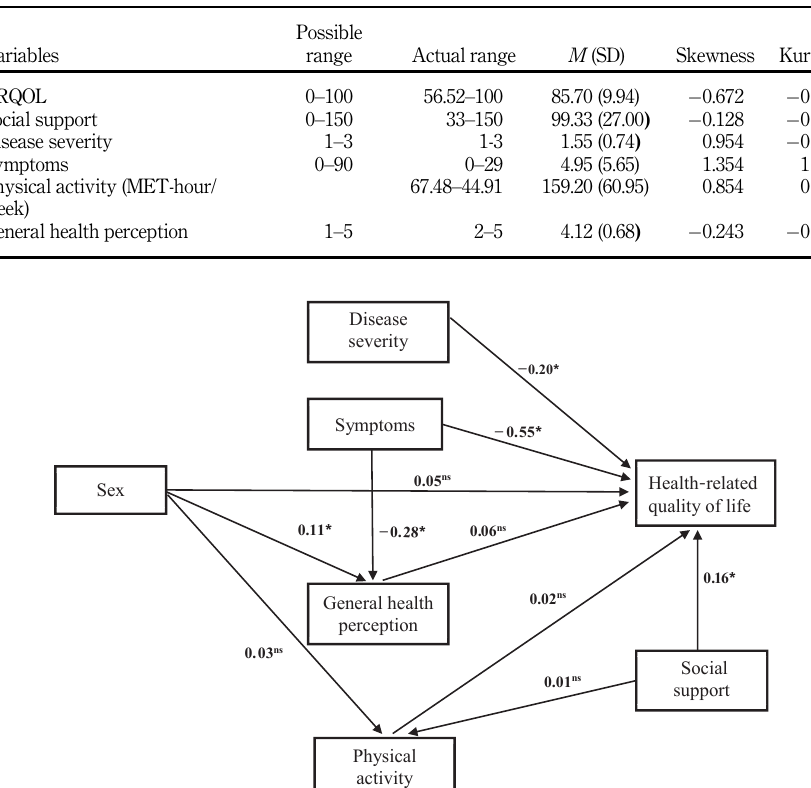
Figure 2. The final model of HRQOL among adolescents with